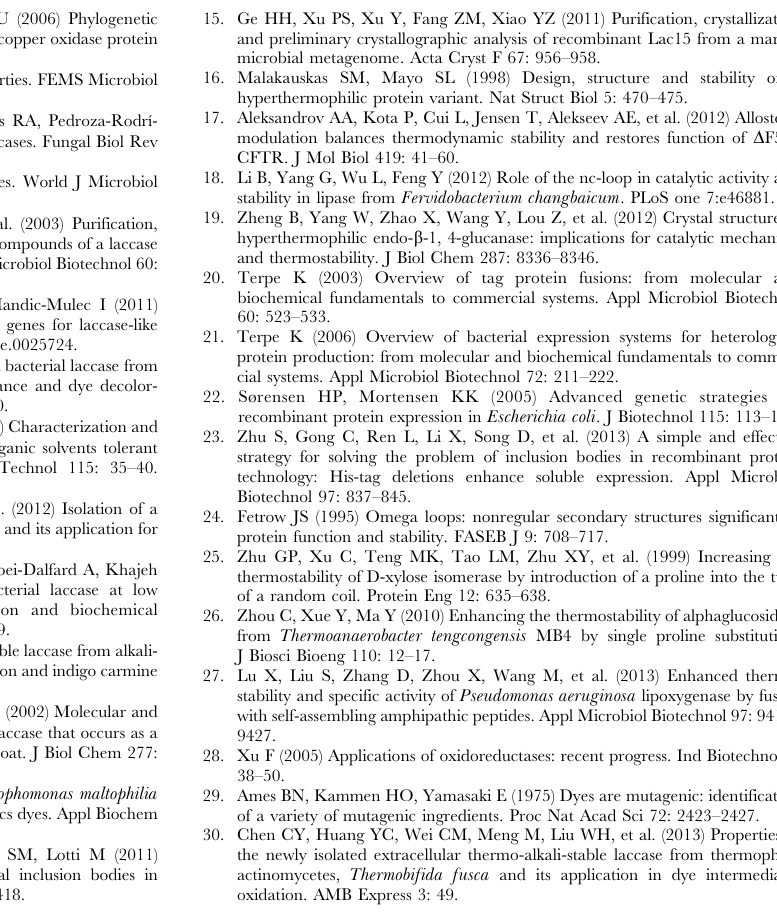
Table S1 Primers used in plasmids construction steps.